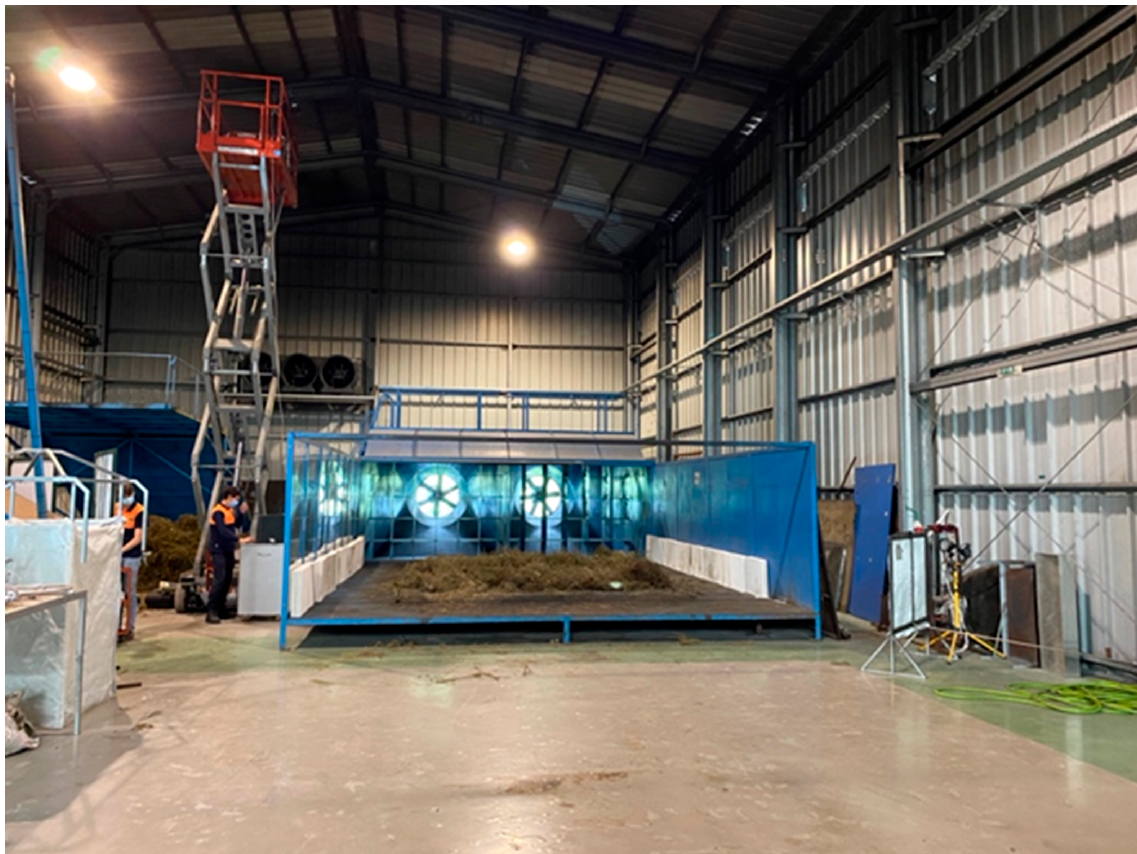
Figure 2. Combustion tunnel CT3. The existence or not of protection and the existence of sidewalls (which avoid lateral air entrainment, promoting the arrival of a structured front, without an edge effect) were tested. The list of tests performed and the respective variables are presented in Table 2 and they were performed in random order. These types of tests are very time consuming and require a lot of laboratory equipment. Preliminary tests were carried out to assess the need to repeat the tests for the purpose of evaluating the effectiveness of the thermal protection. As the recordings of the temperatures and heat fluxes were consistent, this showed a stable evolution without significant random oscillations. A single test was performed for each type of